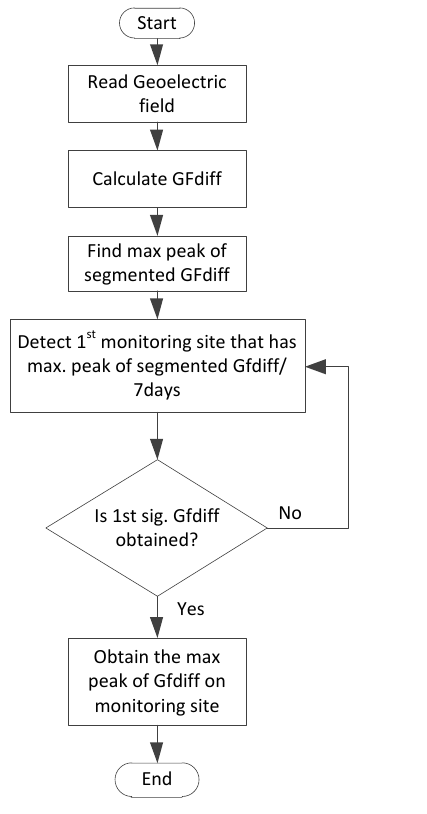
Fig.5. Flowchart for algorithm of determination of the 1 st significant change of geoelectric field prior to an EQ. Fig. 5. Flow chart for algorithm of the determination of the 1st sig- nificant change in geoelectric field prior to an EQ.